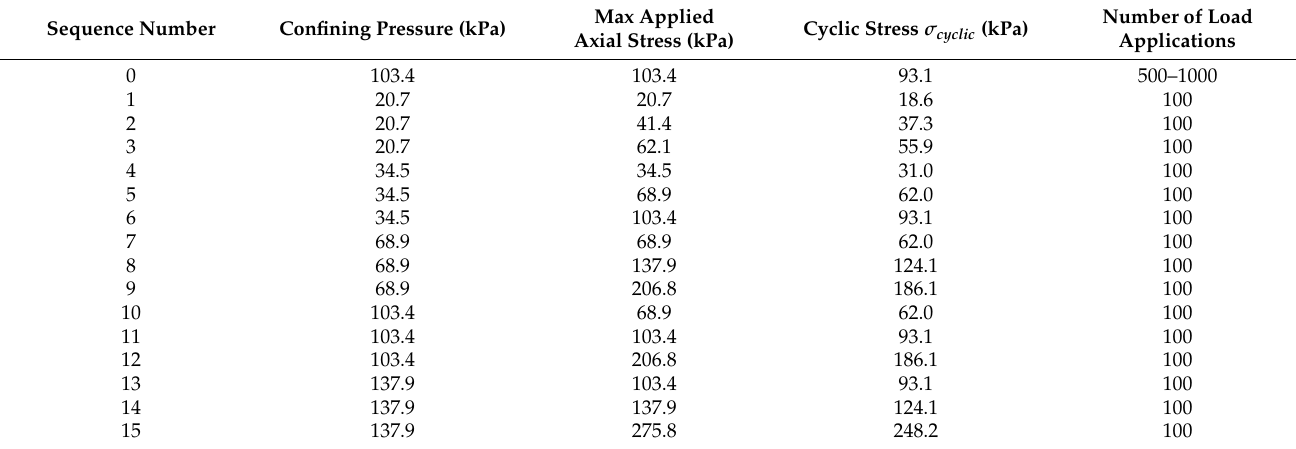
Table 2. Examination sequences for base or subbase material [7].